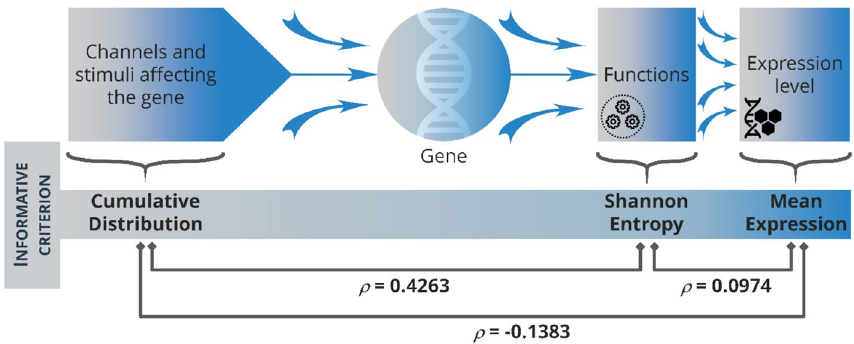
Figure 1. Diagram summarizing the meaning of the Cumulative Distribution, Shannon Entropy and Mean Expression level criteria, as well as the relationship between them.